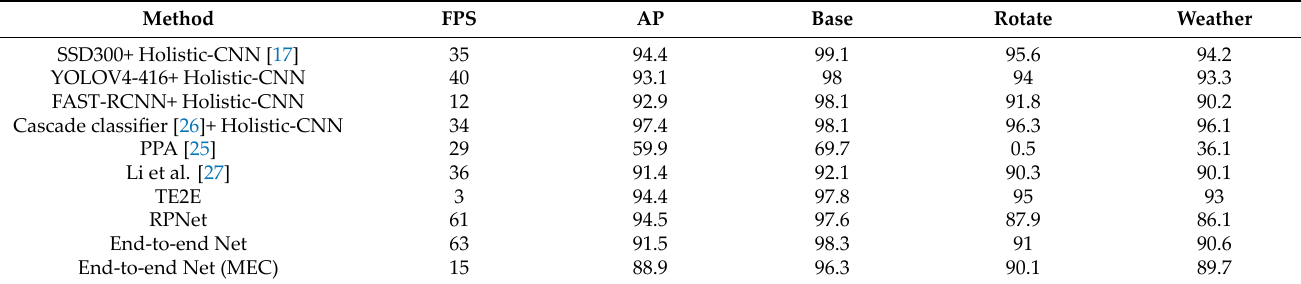
Table 7. Comparative experimental results of license plate detection and character